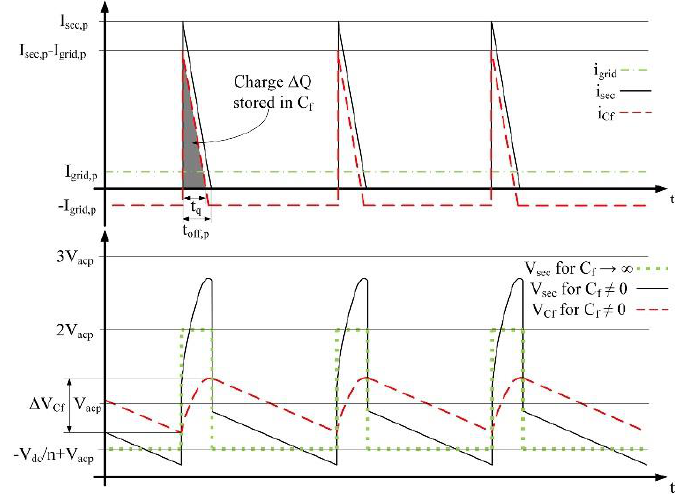
Figure 3. Current and voltage waveforms considering the C f capacitance value near ω t = π /2. The maximum capacitor fluctuation will occur under nominal converter output power at ω t = π /2. Therefore, as shown in Figure 2, the converter will operate in the i-BCM